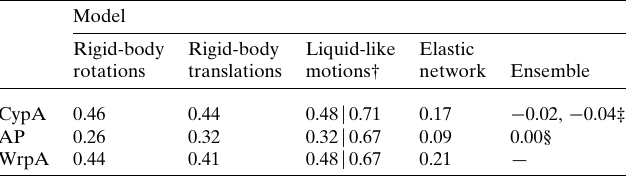
Table 2 Correlation coefficients between predicted and experimental maps. Model